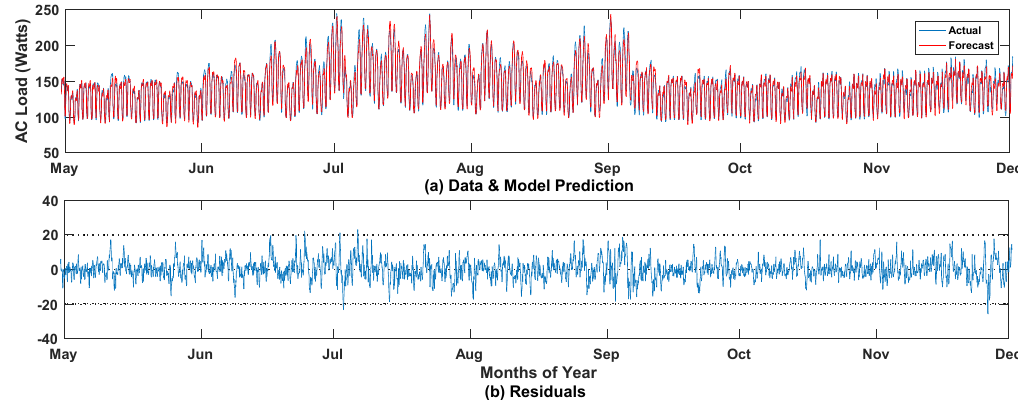
Figure 7. Actual and forecasted AC load by LMA-based ANN approach.